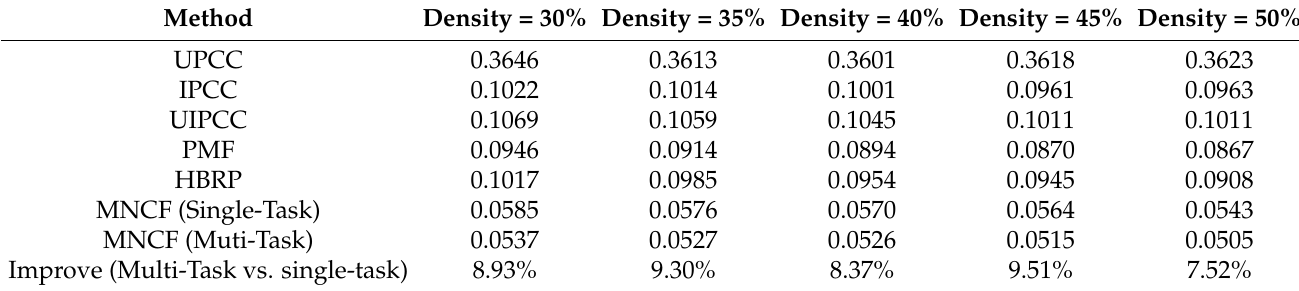
Table 1. Performance Comparison of RMSE of Prediction Models (MaxBlockBack = 12, MaxRTT = 1000). Method